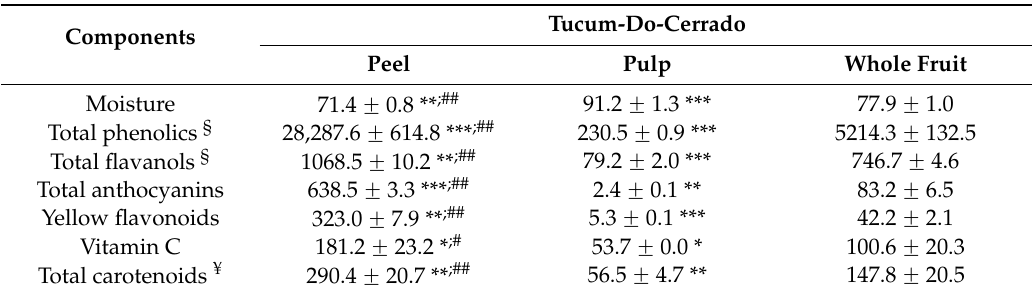
Table 1. Moisture content (%) and phytochemical compounds (mg/100 g) of tucum-do-cerrado peel, pulp and whole fruit expressed as fresh